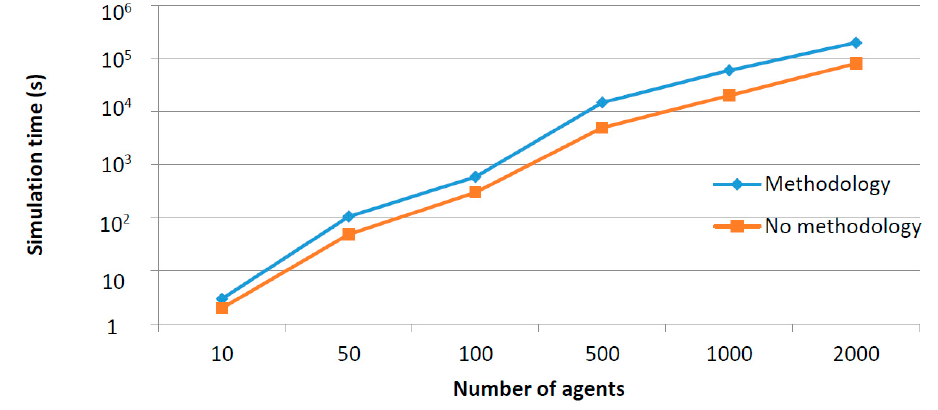
Figure 16. Simulation time along the number of involved people.